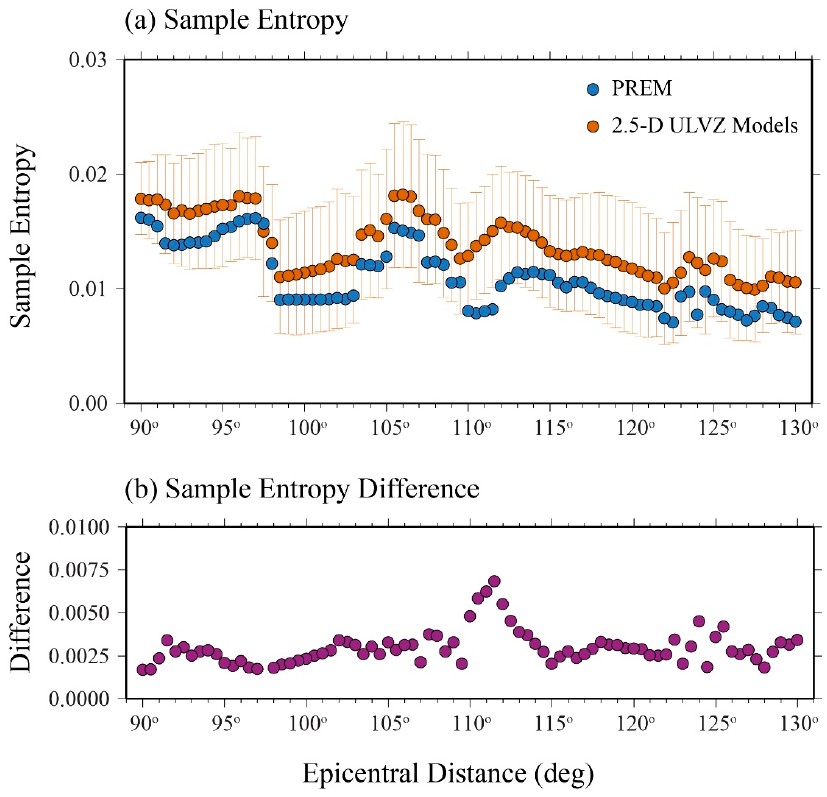
Figure 8. Sample entropy as a function of epicentral distance. ( a ) The SE is shown for the PREM model (blue circles) and the average of all 2.5-D ULVZ models (orange circles) with error bars showing the standard deviation. ( b ) The difference in SE between the average ULVZ values and PREM is shown (purple circles).